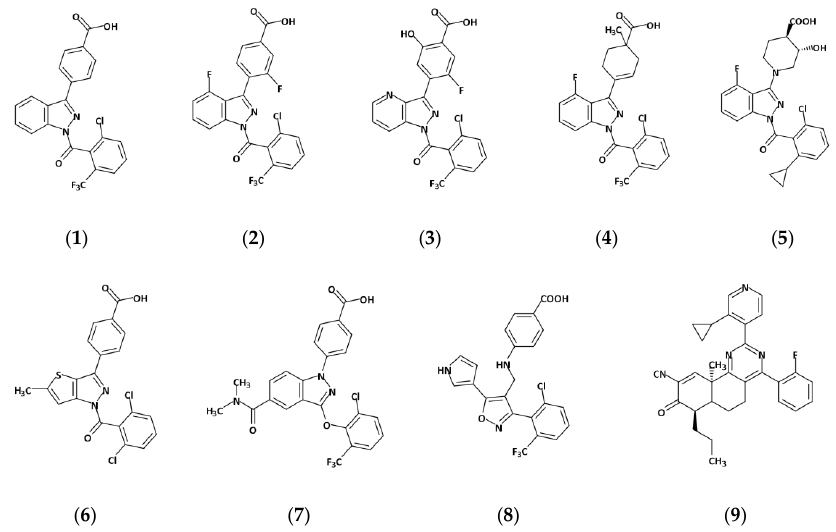
Figure 7. Allosteric inverse agonists binding in the AF-2 site. The corresponding PDB codes for the co-crystal models of the compounds binding in the RORγ LBD are listed as follows: ( 1 ) 4YPQ, 5C4O [11]; ( 2 ) 5C4S [11]; ( 3 ) 5C4U [11]; ( 4 ) 5C4T [11]; ( 5 ) 6UCG [37]; ( 6 ) 6TLM [38]; ( 7 ) 5LWP [39]; ( 8 ) 6SAL [40]. No PDB code is available for compound ( 9 ) [41].